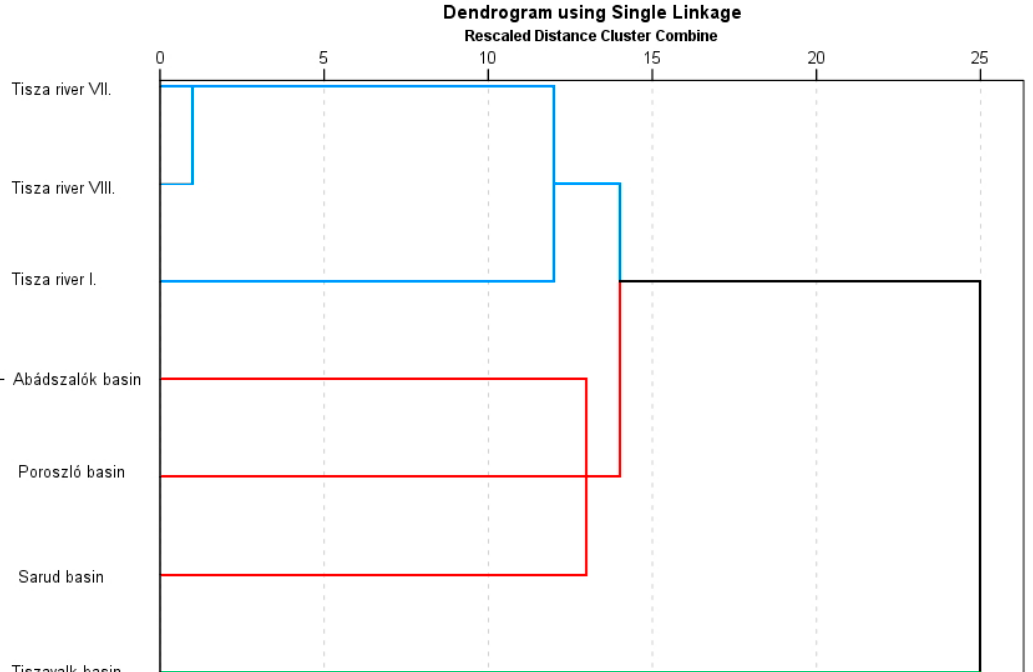
Figure 9. Dendrogram, representing the HCA results. A two-step cluster analysis was conducted to classify groups based on the given parameters and to identify the weight of each variable in the clustering process.